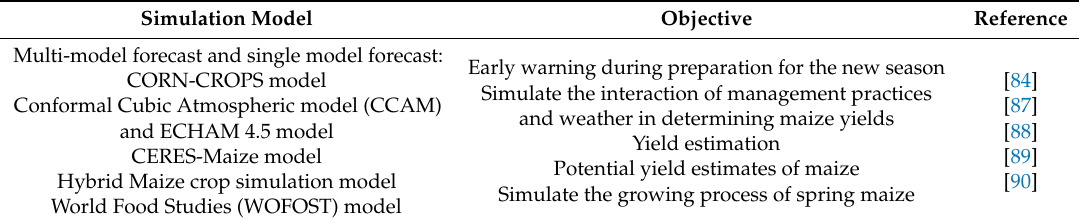
Table 2. Some simulation models applied in maize